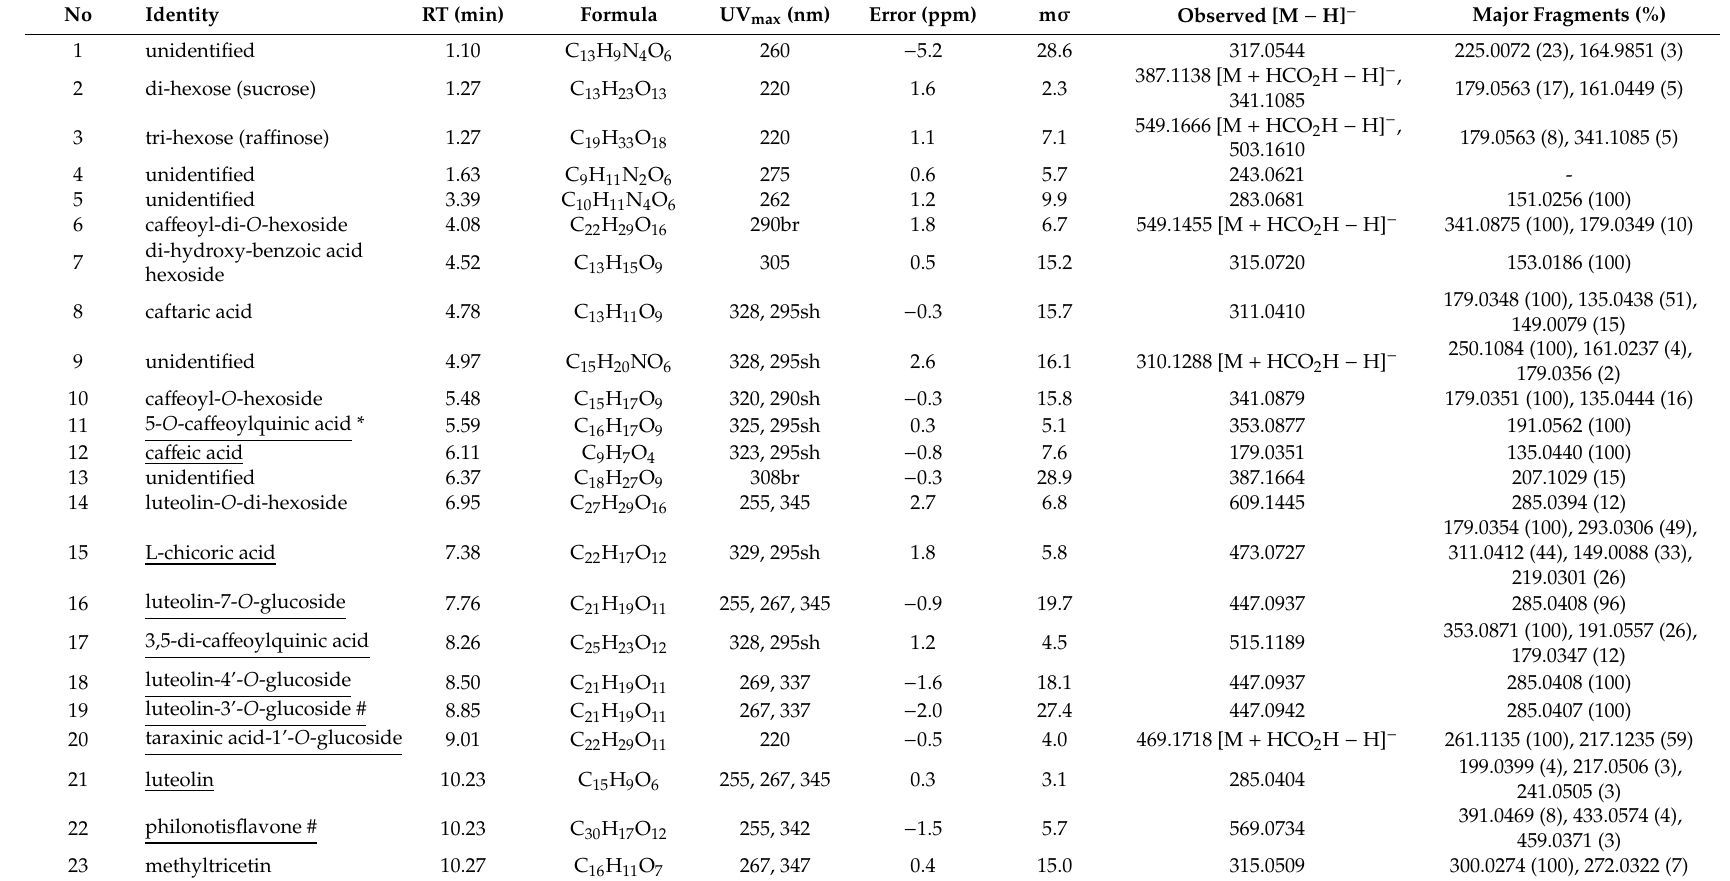
Table 1. UHPLC-QTOF-MS / MS data of metabolites identified in the methanol extract (E1) of Taraxacum o ffi cinale L.